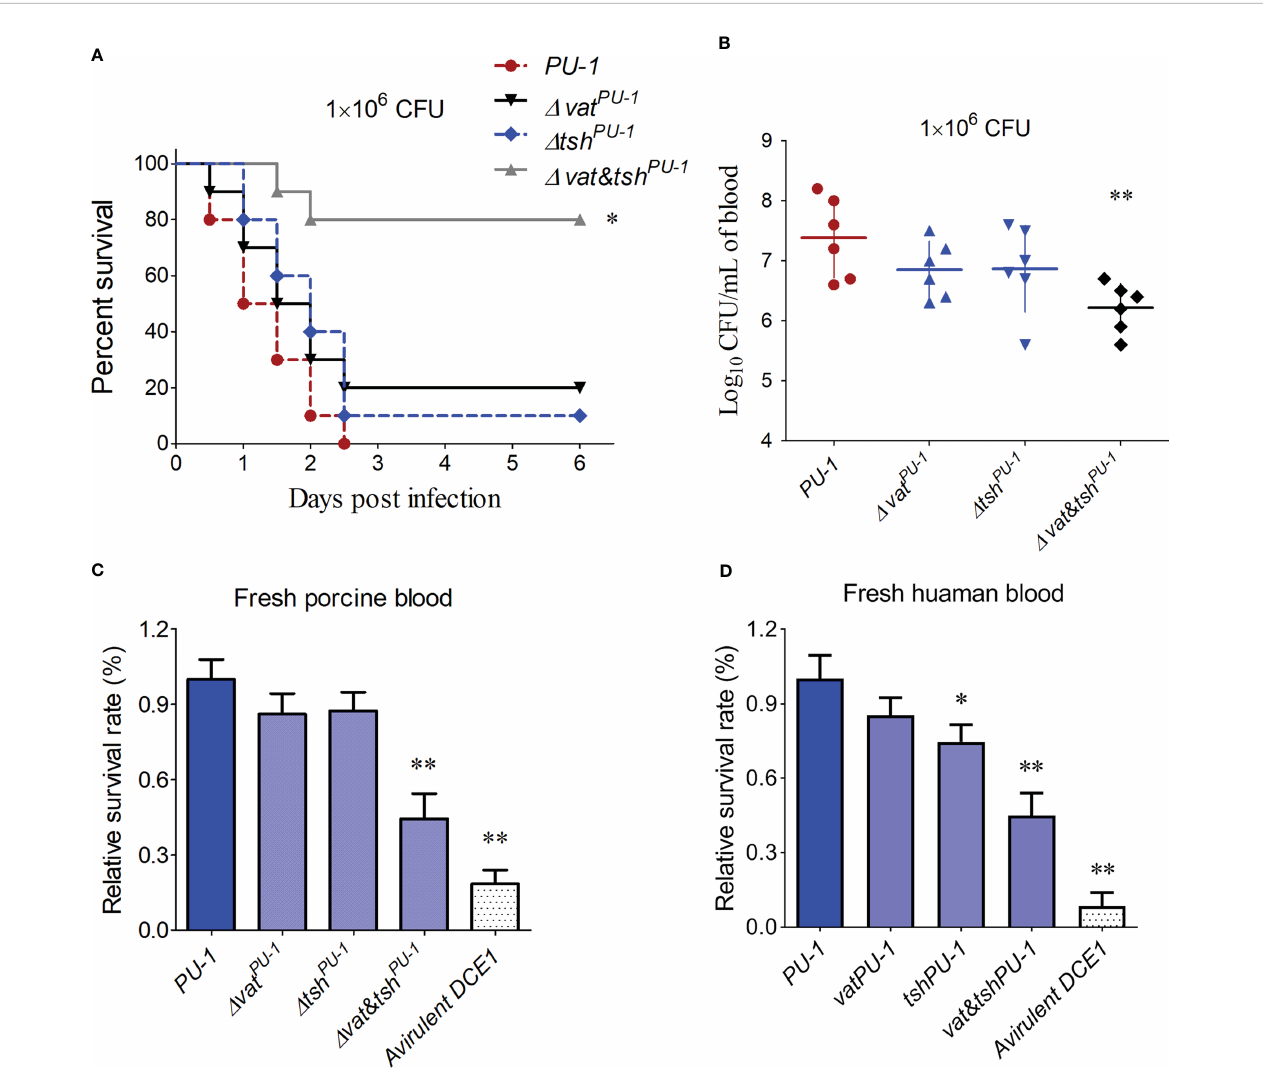
FIGURE 3 Mouse infection assay identi fi ed the pathogenic roles of VatPU-1 and TshPU-1. (A) Effect of vat PU-1 or tsh PU-1 deletion on strain PU-1 pathogenicity. Survival curve of mice infected with 1 × 10 6 CFU/mouse bacteria (ten mice per group). (B) Systemic infection experiment was conducted to assess bacterial load in mouse blood. Bacterial reisolation from the blood at 16 h post-inoculation was quanti fi ed by plate count. (C, D) Porcine and human bloods were then used to assess the bacterial survival of indicated ExPEC strains. The survival rates were calculated by measuring the bacterial counts. Statistical signi fi cance was determined by a one-way ANOVA test (**P < 0.01, *P <